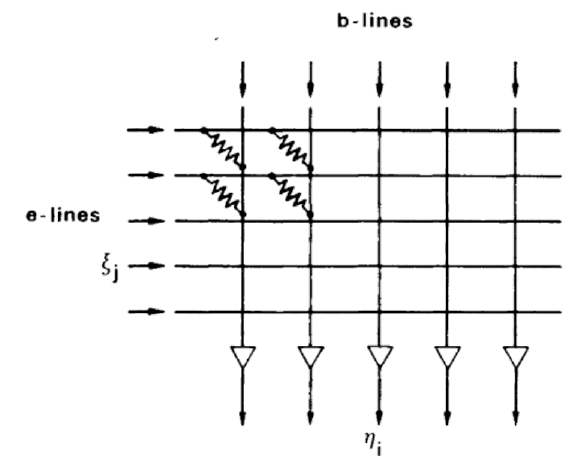
Figure 4. Learning matrix, introduced by Steinbuch [51], reproduced with permission from